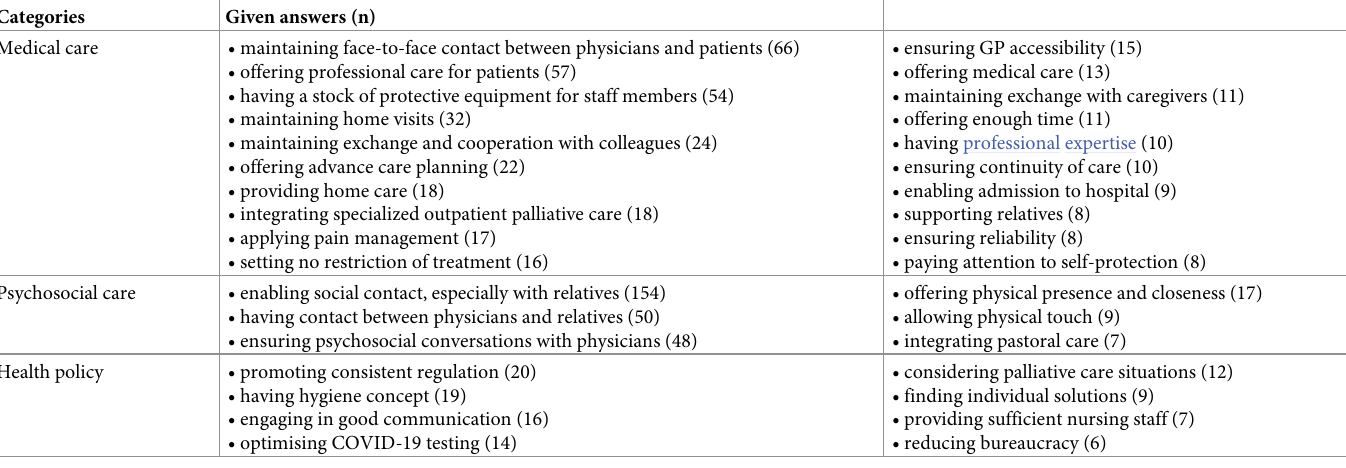
Table 5. Most important aspects of palliative patient care in pandemic times (up to three free text comments per person